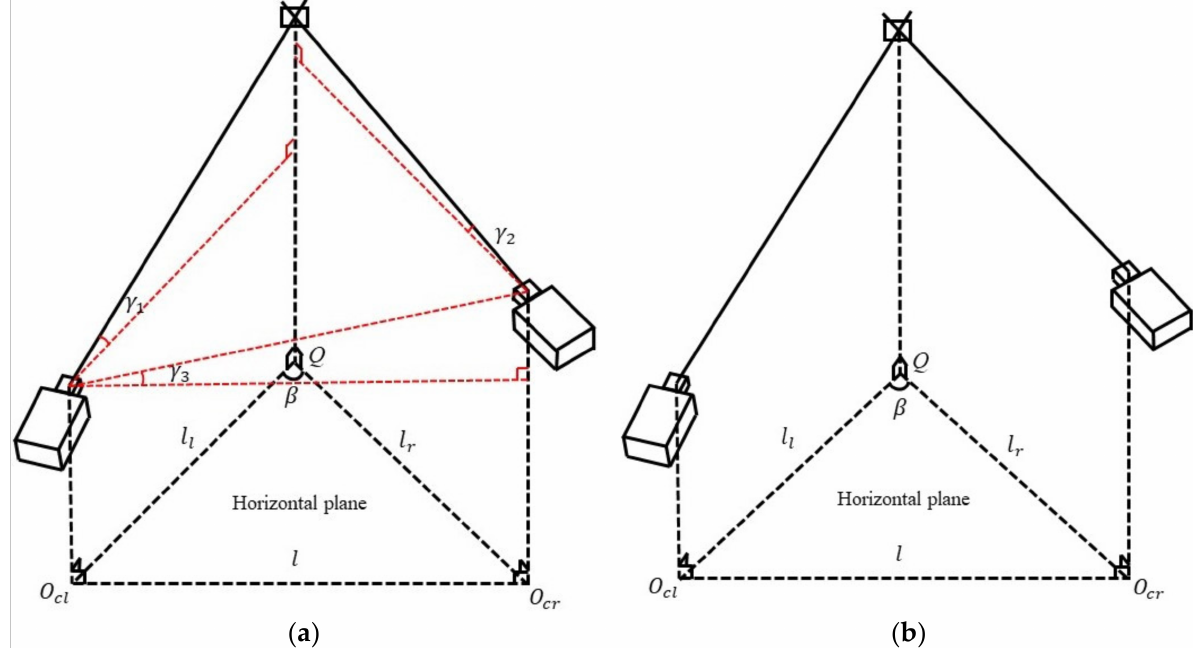
Figure 3. Relative attitude angle calculation: ( a ) using laser rangefinder and inclinometer; ( b ) using